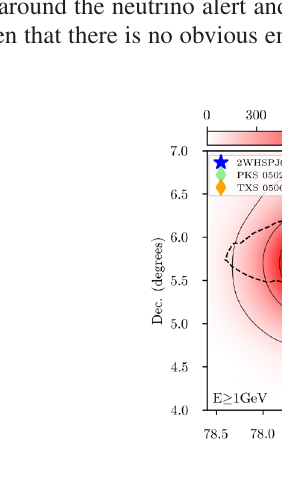
Figure 2. Left : The test-statistic map of the region during the neutrino flare in 2014 / 2015. PKS 0502 + 049 is the dominant γ -ray emitter in the sky. Above 2 GeV the sources are disentangled and above 5 GeV TXS 0506 + 056 is the dominating source. This is due to the log-parabola spectrum of PKS 0502 + 049 that softens above 934 MeV [10]. For symbol explanation see right plot. Right : The TS map between MJD 57908 and 58018, just before the neutrino alert. Here TXS 0506 + 056 dominates already at 1